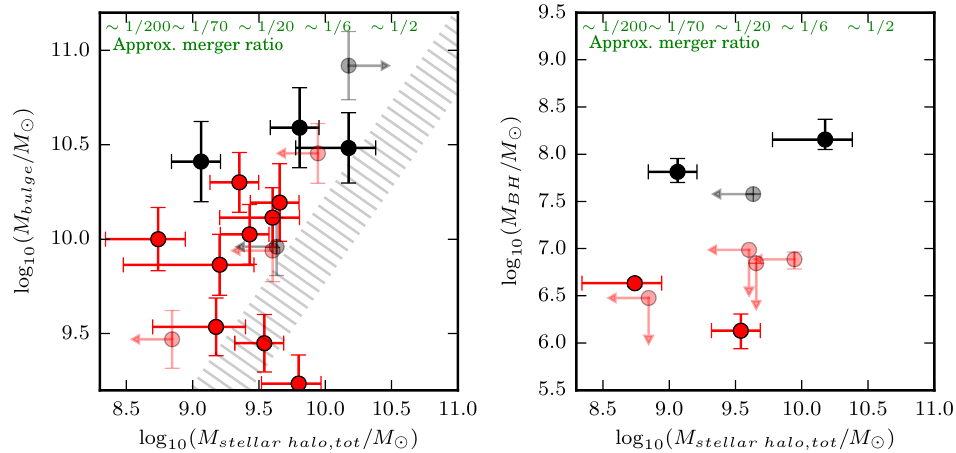
Figure 4. Bulge mass (left) and BH mass (right) as a function of stellar halo mass. Red denotes galaxies with low-mass “pseudobulges”, black shows galaxies with higher-mass “classical” bulges; observational limits are shown with lighter shading. As argued in Figure 3, stellar halo mass reflects merger history, and approximate merger ratios are given in green. The shaded area in the left panel schematically illustrates what would be expected if there were a 1:1 correlation between stellar halo mass and bulge mass, as broadly expected in some simple modeling contexts (e.g., [1]). Figure 2 from [9], reproduced with permission of the